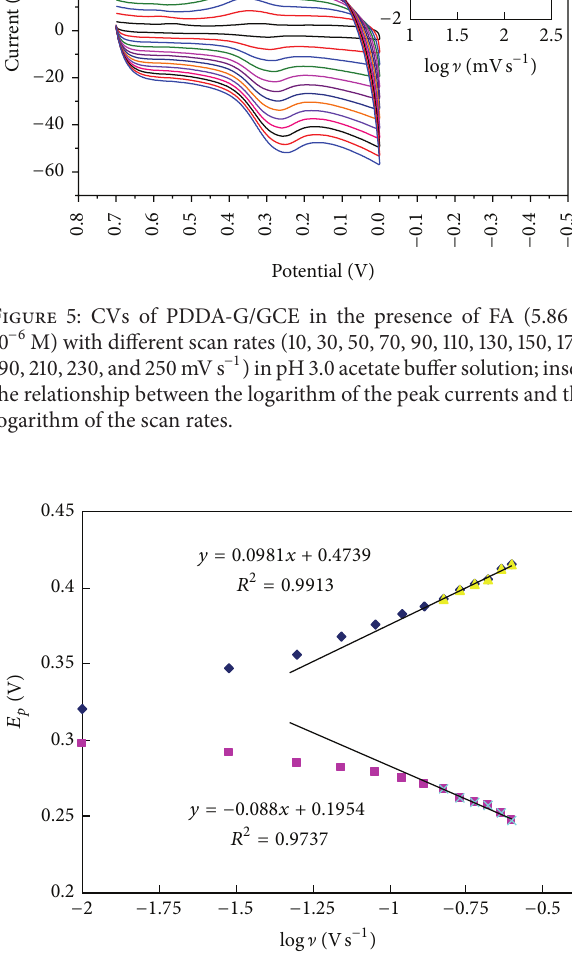
Figure 6: The plots of the anodic and cathodic potentials against the logarithm of scan rates.